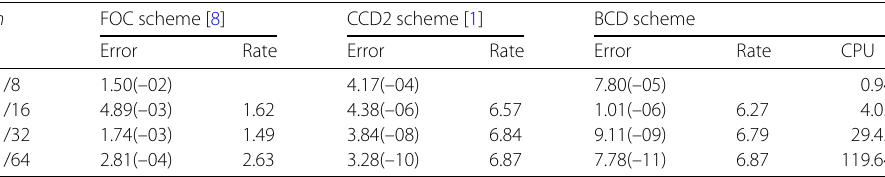
Table 5 The maximum error and convergence rate for Problem 3 with Re = 10 4 h